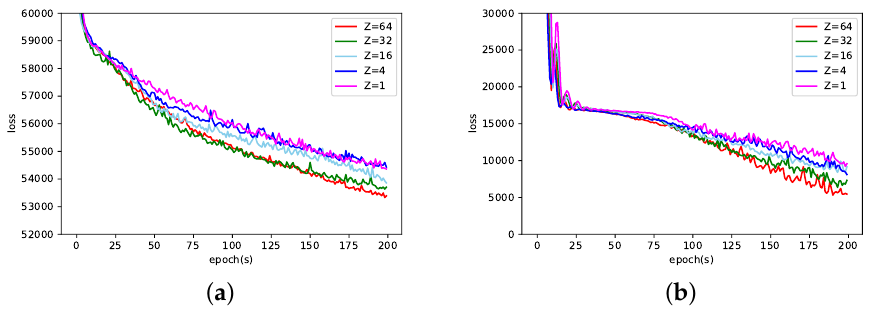
Figure 13. Comparison concerning varying memory size Z for the training loss curve on two datasets. ( a ) Twitter; ( b )